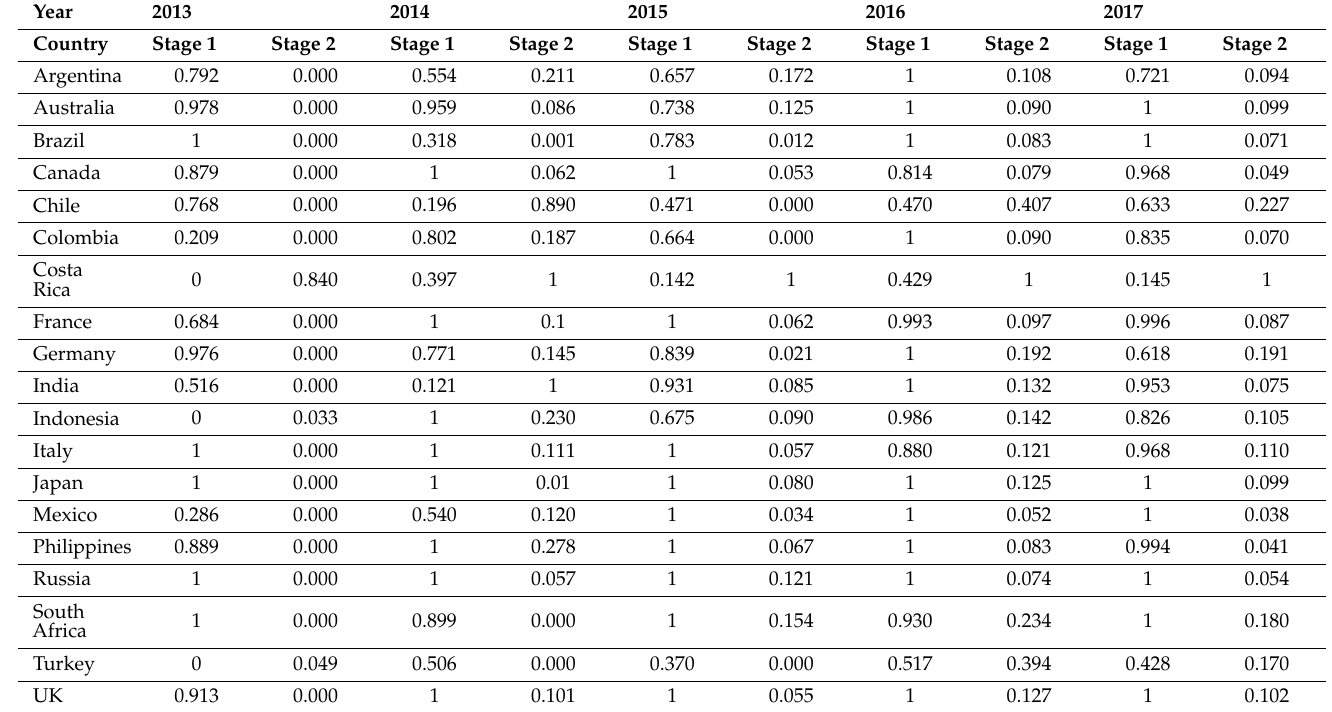
Table 5. Efficiency of two stages from 2013 to